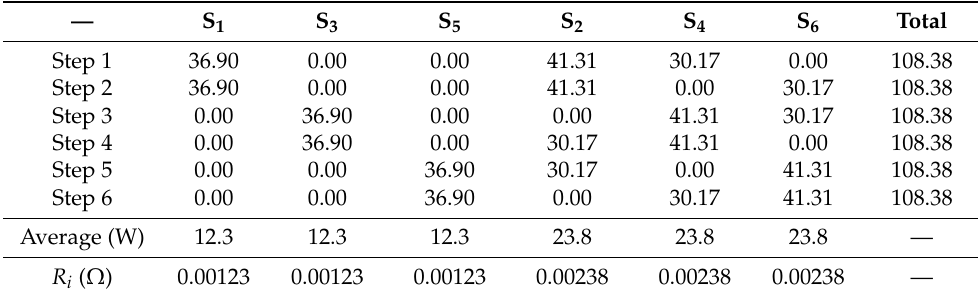
Table 4. Power losses and equivalent resistances of these six inverter switches during one PWM six-step commutation cycle at 200 °C.